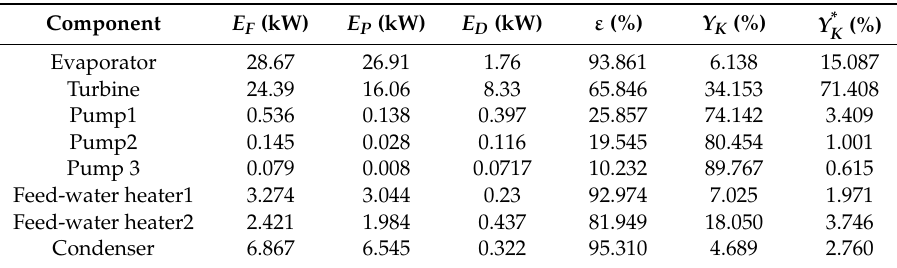
Table 7. Results from exergy calculations for